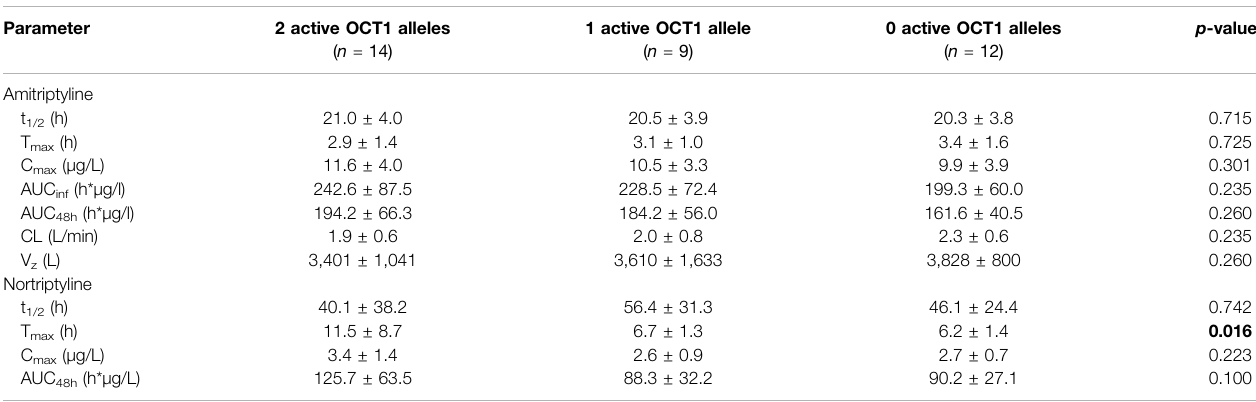
TABLE 2 | Pharmacokinetic parameters strati fi ed by OCT1 genotype.